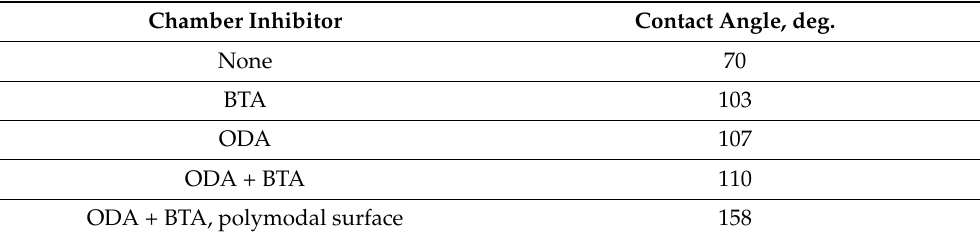
Table 7. Effect of CT on the θ of steel wetting by distilled water. T CT = 120 ◦ C, τ CT = 1 h. Chamber